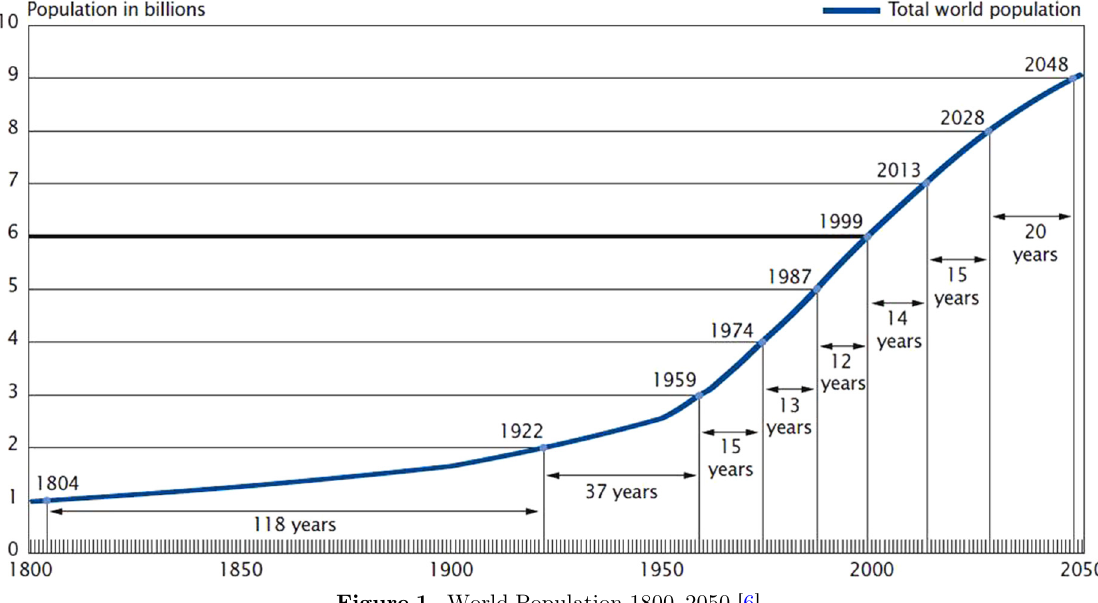
Figure 1. World Population 1800 – 2050 [6].